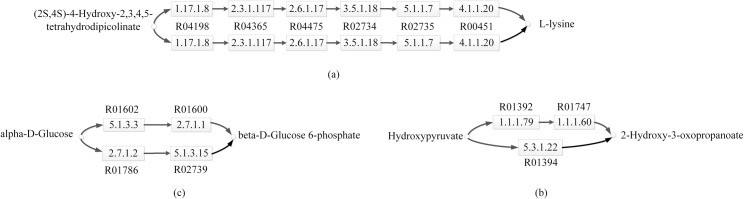
Sample alignments.The upper reactions are a part of the pathways of atc, whereas the lower reactions are a part of the pathways of eco. Reactions are represented by their KEGG identifiers. Enzymes are shown in EC numbers. The compounds are depicted by small circles. (a) One-to-one reaction mappings extracted from the alignment of the metabolic pathways of lysine biosynthesis in atc and eco. (b) A one-to-many reaction mapping extracted from the alignment of the metabolic pathways of Glyoxylate and dicarboxylate metabolism in atc and eco. (c) A many-to-many reaction mapping extracted from the alignment of the metabolic pathways of Glycolysis in atc and eco.